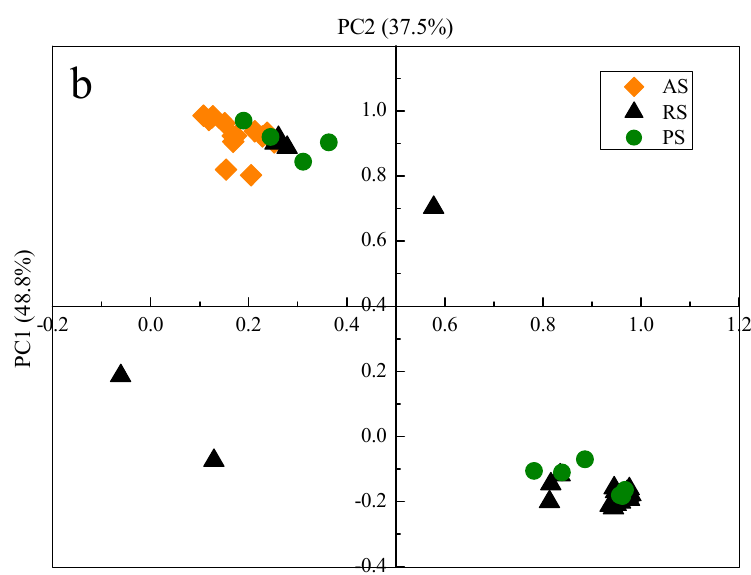
Figure 6. Principal Component Analysis loading plot for ( a ) 16 individual PAHs and ( b ) different sample sites.